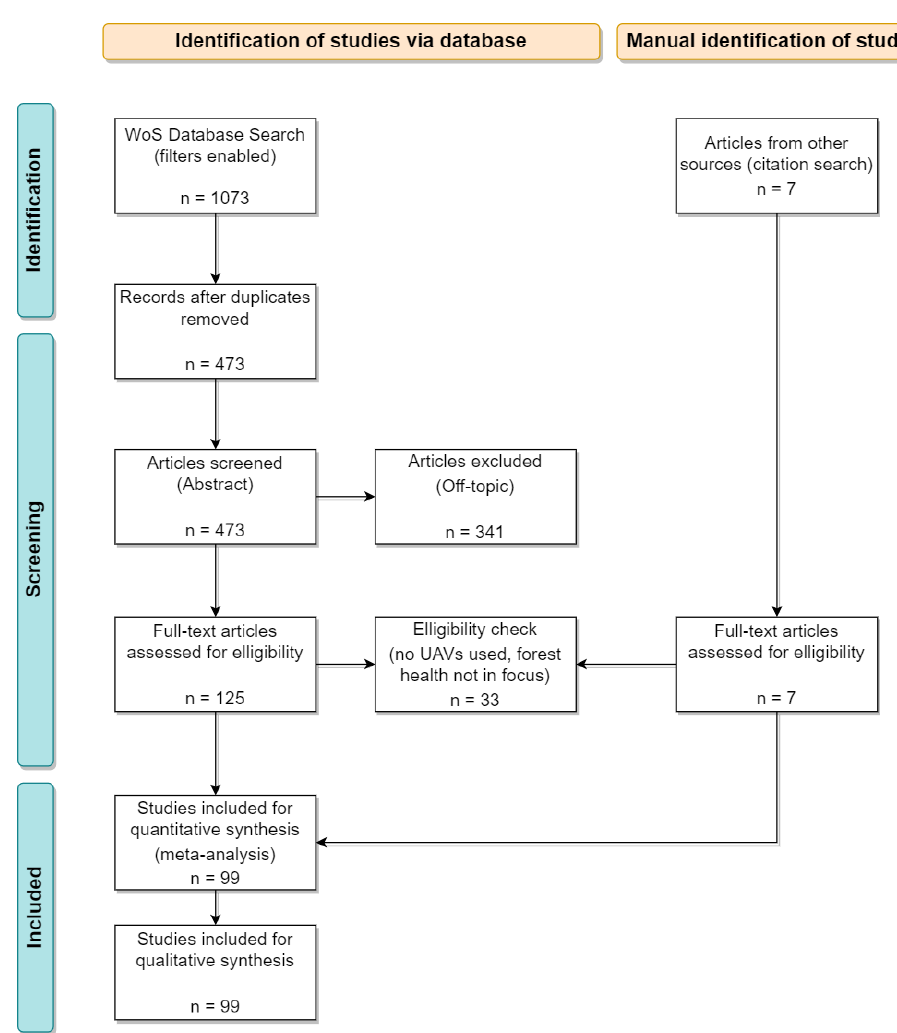
Figure 5. PRISMA flow diagram depicting the different phases of the bibliographic dataset creation ( n = number of